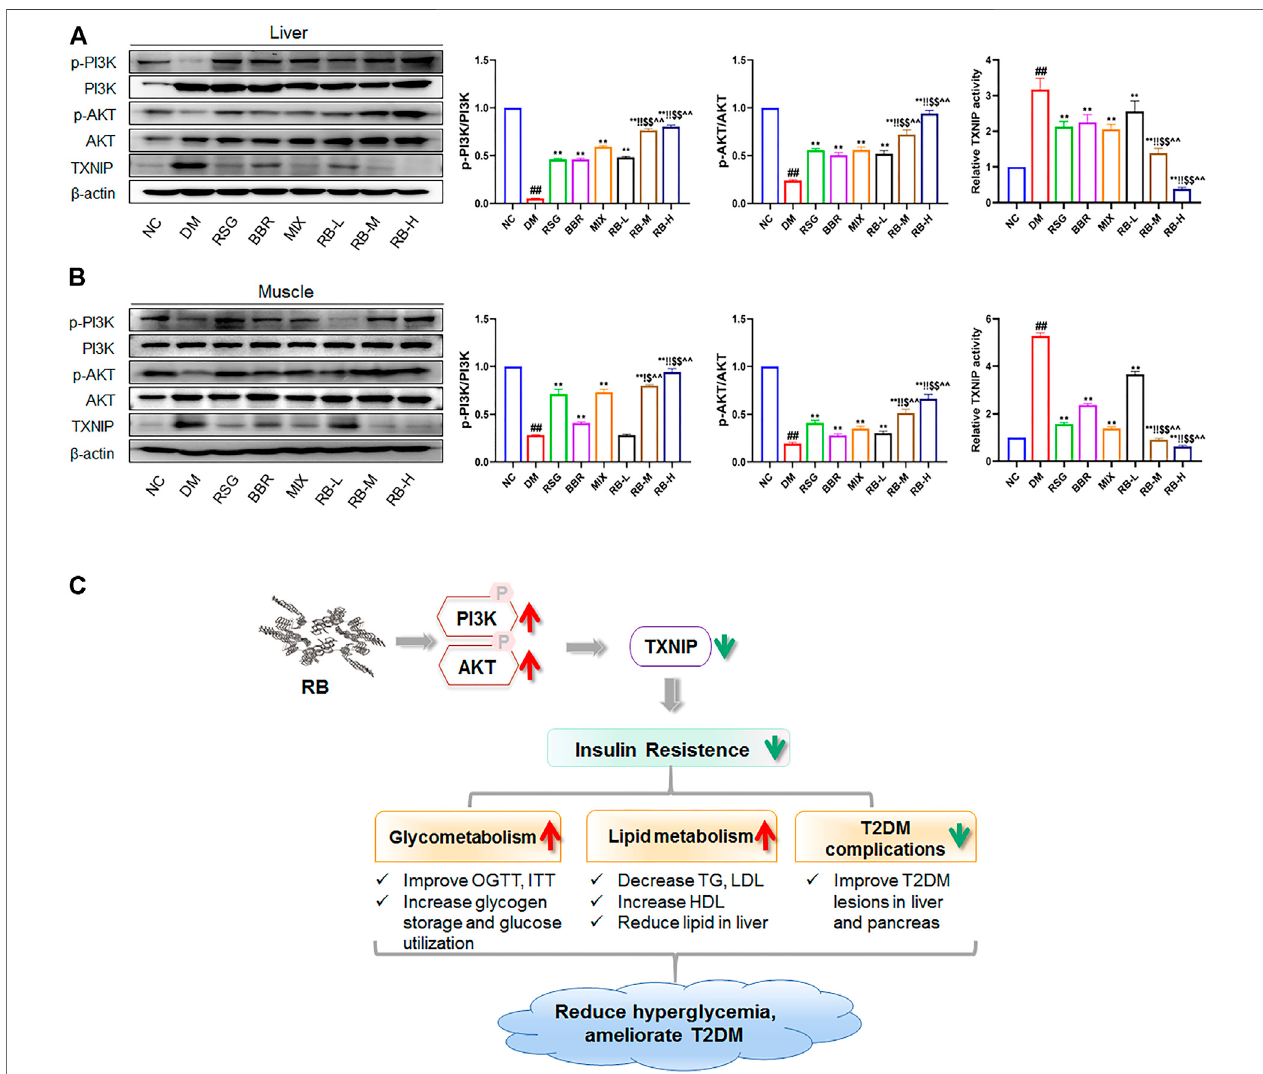
FIGURE7| RBamelioratedinsulinresistancebyupregulatingthePI3K/AKT/TXNIPcascadesignalingpathway invivo . (A) EffectofRBontheexpressionofp-PI3K, PI3K, p-AKT, AKT, and TXNIP proteins in the liver of KKAy mice; (B) Effect of RB on the expression of p-PI3K, PI3K, p-AKT, AKT, and TXNIP proteins in the muscle of KKAy mice. (C) Schematic map for RB improving insulin resistance and T2DM. All data are represented asthe mean ± SD ofthree independent experiments. # p < 0.05, ## p < 0.01,vs.NCgroup;* p < 0.05,** p < 0.01,vs.DMcontrolgroup; $ p < 0.05, $$ p < 0.01,vs.RSGgroup; ^ p < 0.05, ^^ p < 0.01,vs.BBRgroup; ! p < 0.05, !! p < 0.01, vs. MIX